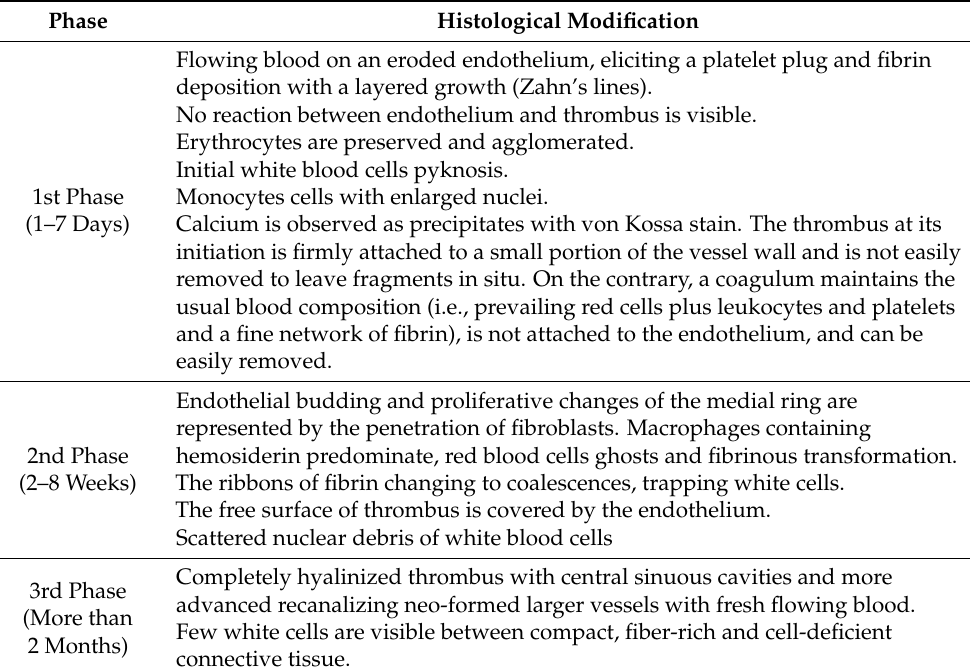
Table 3. Histological age determination of thromboses and embolisms according to Fineschi et